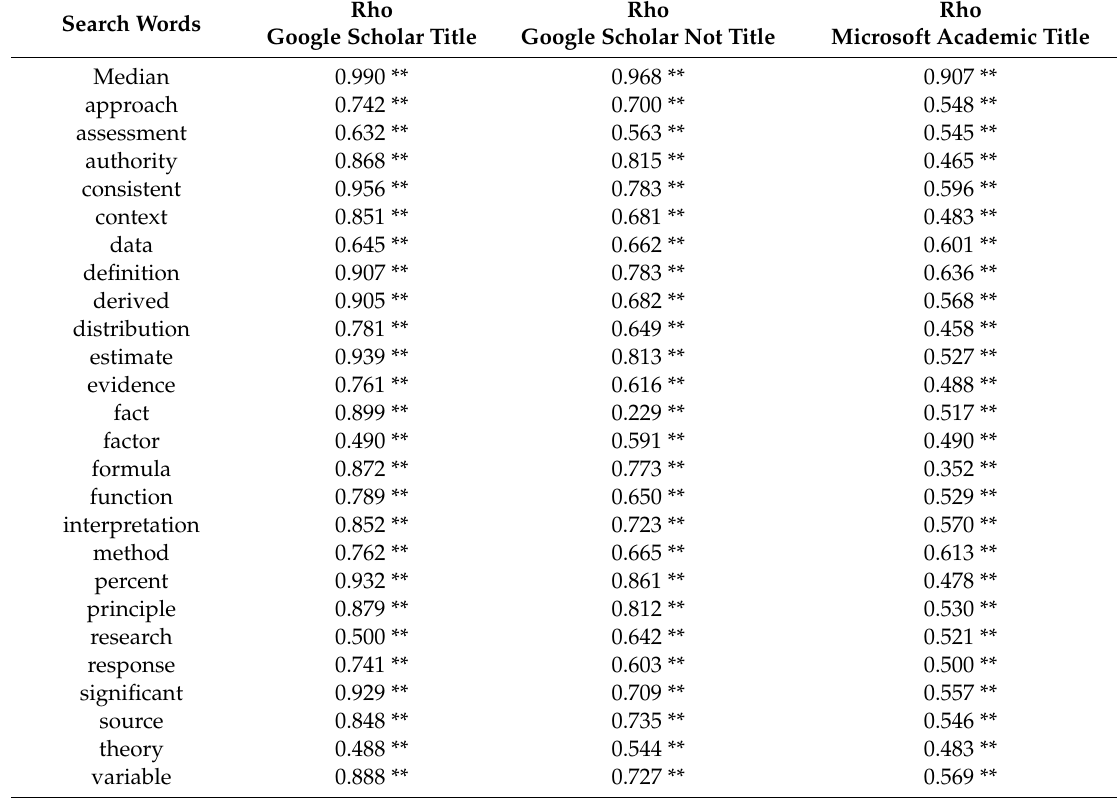
Table A1. Words and Rho of one-term searches. ** p <